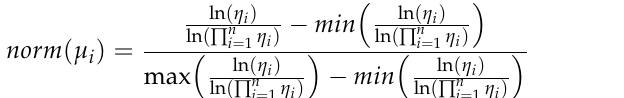
Figure 5. Viscosity variation of the fresh mixtures and marks of segregated sand samples.